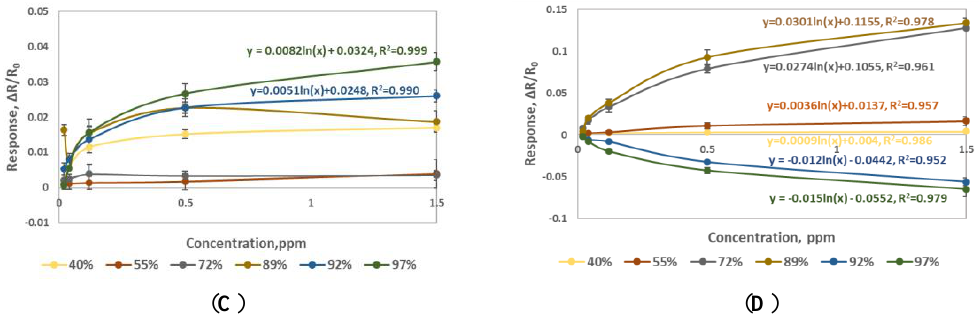
Figure 6. Responses (ΔR/R 0 ) to 0.02, 0.04, 0.12, 0.5, 1.5 ppm NO gas in 40%, 55%, 72%, 89%, 92% and 97% RH ( A ) Material 1 nanocomposite sensor response ( B ) Material 2 nanocomposite sensor re- sponse ( C ) calibration plots for Material 1 ( D ) calibration plots for Material 2.